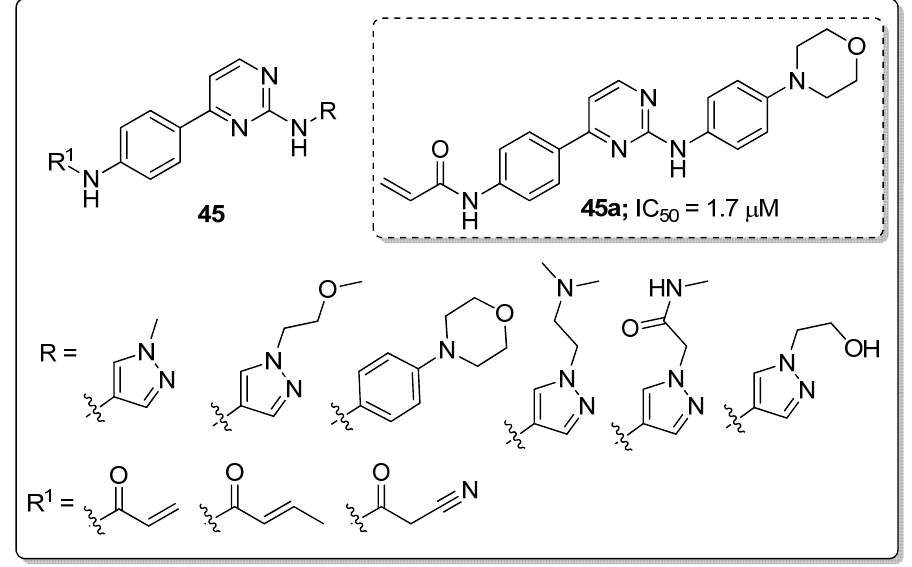
Figure 52. Most active pyrimidine scaffold 45a as a JAK3 inhibitor.